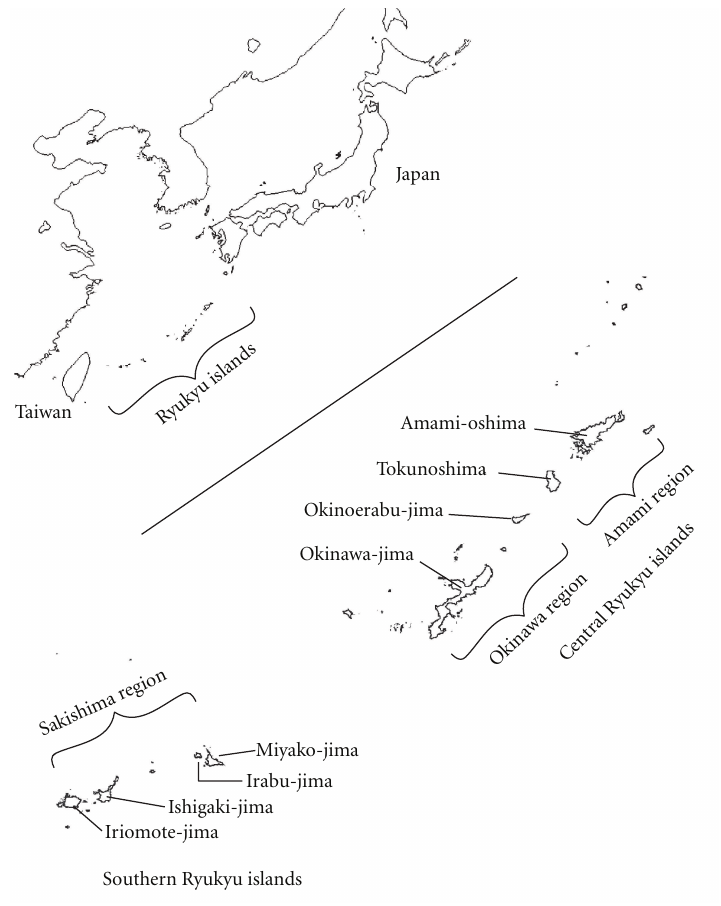
Figure 1: Map showing islands where Curtos fireflies were